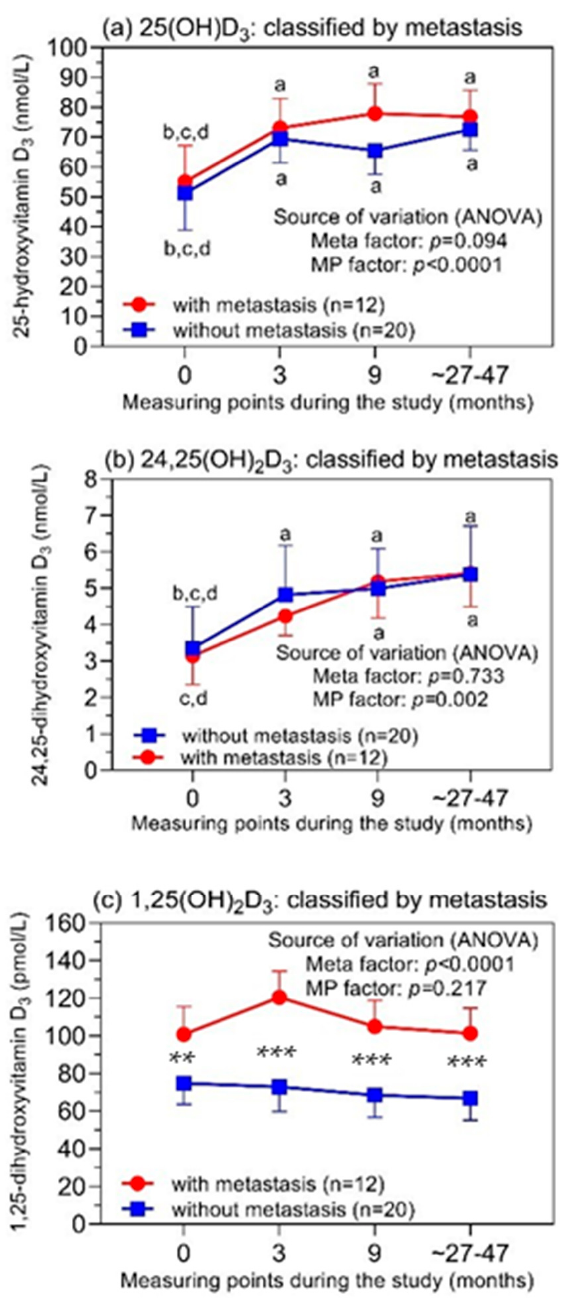
Figure 4. Levels of ( a ) 25(OH)D 3 , ( b ) 24,25(OH) 2 D 3 , and ( c ) 1,25(OH) 2 D 3 in patients with and without developed bone metastases during the study. Repeated measures were performed before the treat ‐ ment (time point = 0) and 3 and 9 months after the treatment start. The last measuring points were 27 and 42 months (mean values) for the patients with ( n = 12) and without ( n = 20) bone metastasis, respectively. Results of the repeated ‐ measures two ‐ factor ANOVA classified according to the factor